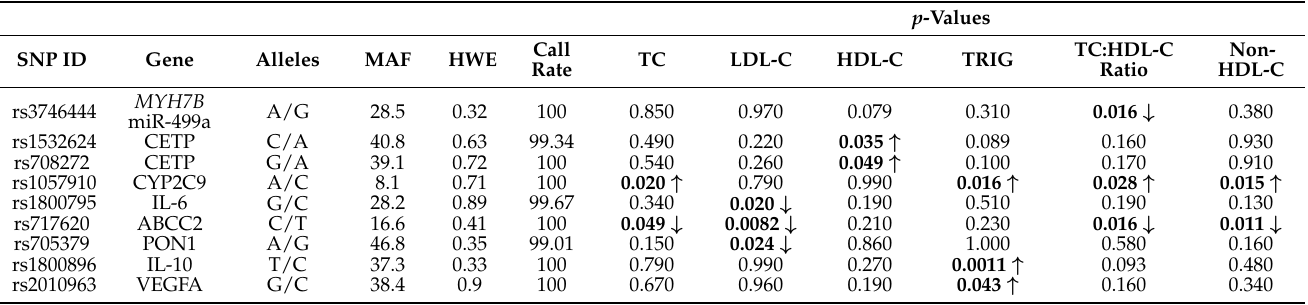
Table 4. Association analyses between polymorphisms and lipid profile in 302 subjects with dyslipidemia on statin lipid-lowering therapy (STAT cohort). p -Values